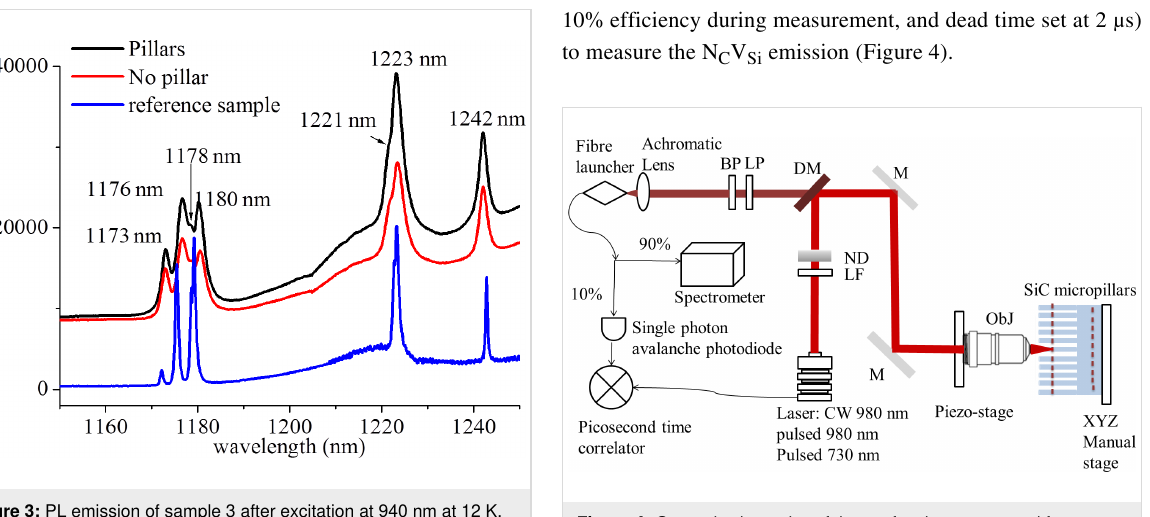
Figure 4: General schematics of the confocal systems used for imaging, spectroscopy and lifetime measurements. The schematics of the SiC micropillars sample is magnified and not to scale for illustra- tion purposes. In the first confocal microscopy setup a variable wavelength super continuum NKT Photonics, Fianium WhiteLase pulsed laser was used for sample illumination at 730 nm. The laser has a pulse width of 30 ps and a repetition rate variable from 10 MHz to 80 MHz. The excitation wavelength to perform